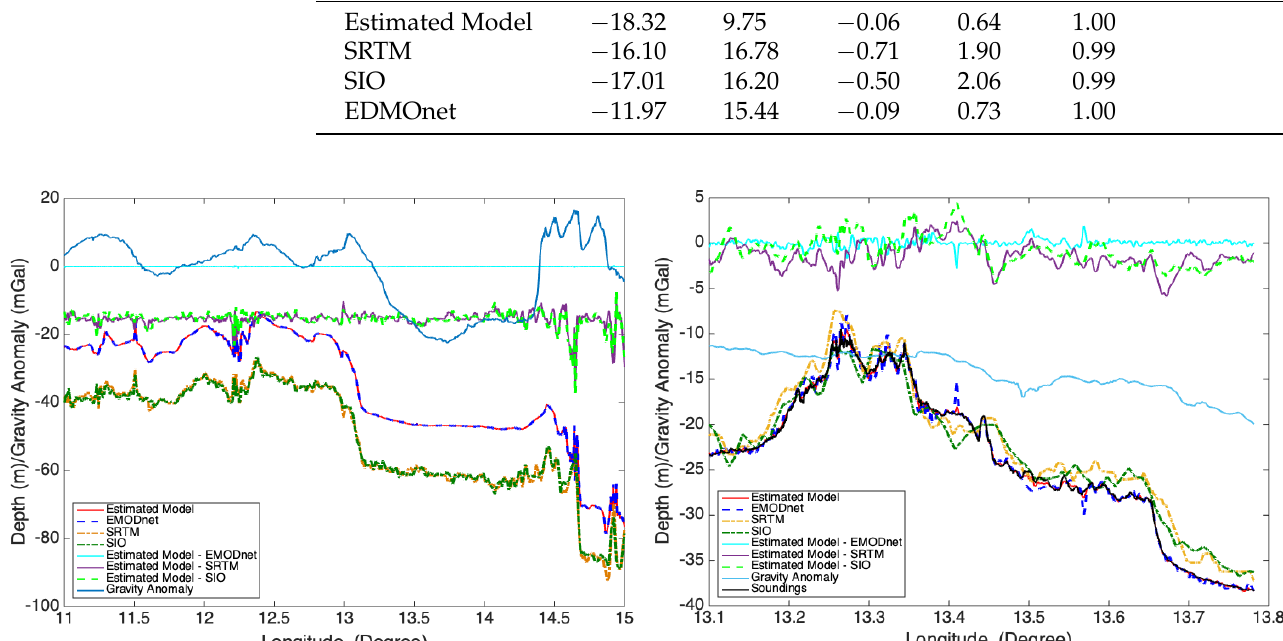
Figure 9. Seafloor topography along two specific tracks from marine gravimetry campaigns onboard the ferry URD, which is across the middle part of the study area, the depth from SRTM model (SIO model) and the differences between estimated model and SRTM model (SIO model) being shifted 15.00 m down for better presenting these data ( left panel ) and that onboard research vessel DENEB together with ship-sounding data, which is near the coast of Sweden ( right panel